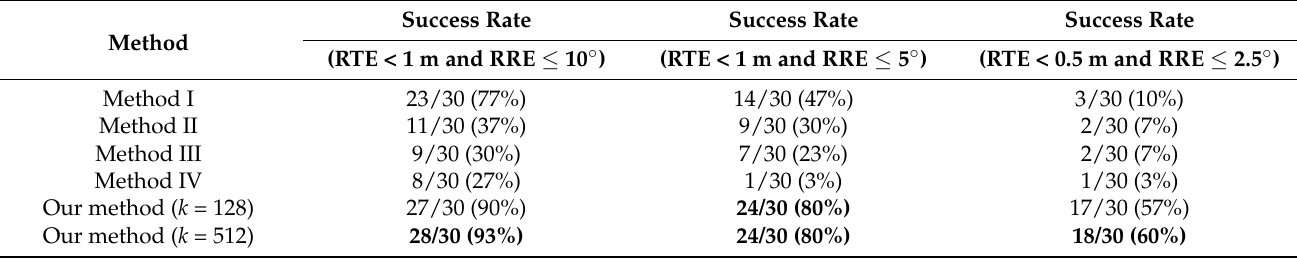
Table 5. The registration success rate of each method in Dataset